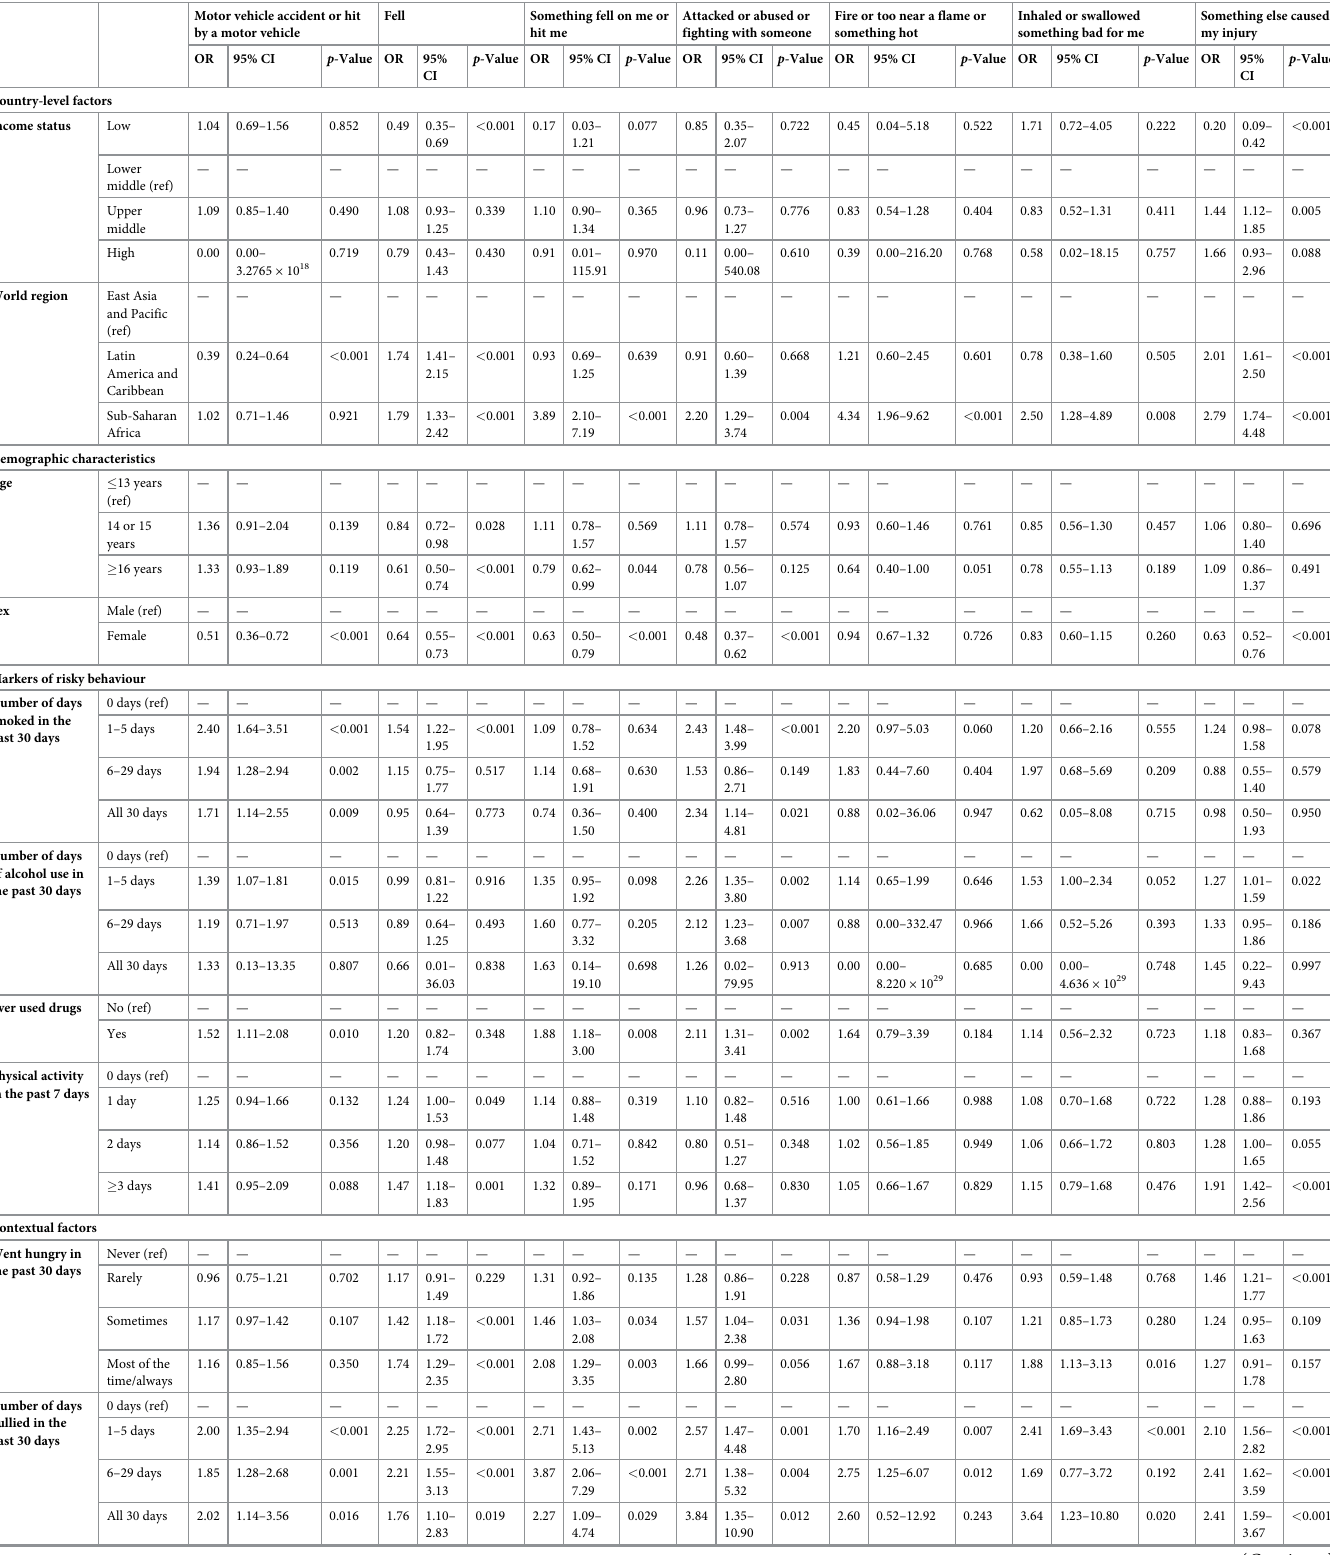
Table 6. Multivariable associations between injury mechanism, country-level factors, and individual-level factors of risky behaviour, contextual factors, protective factors, and indicators of poor mental health. Motorvehicleaccidentorhit